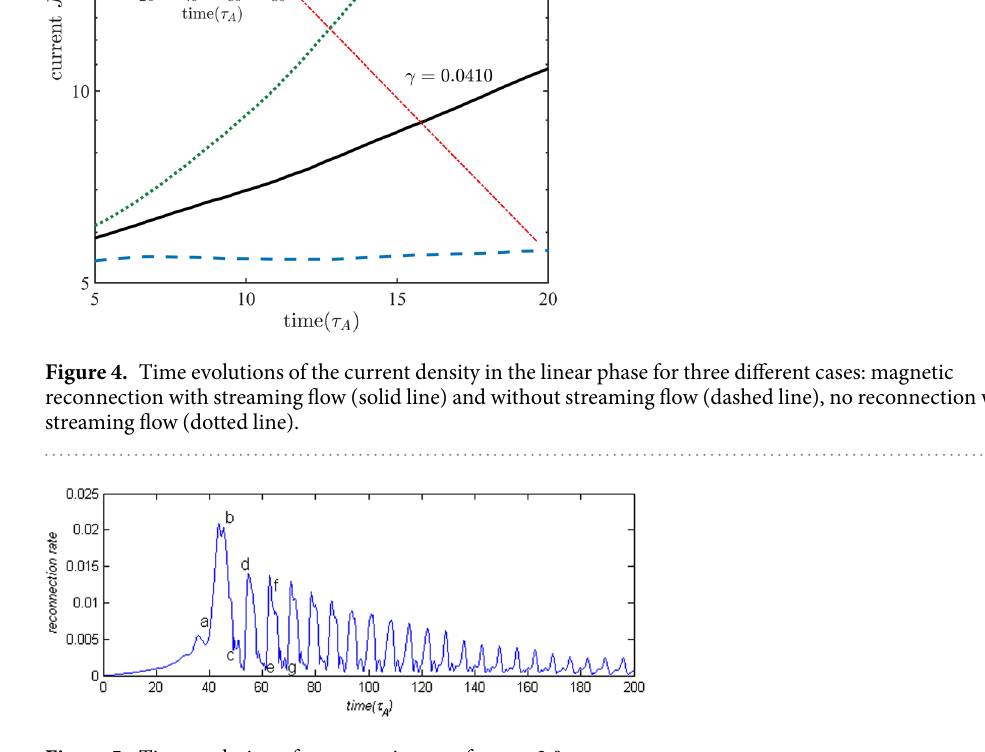
Figure 5. Time evolution of reconnection rate for v 0 = 2.0